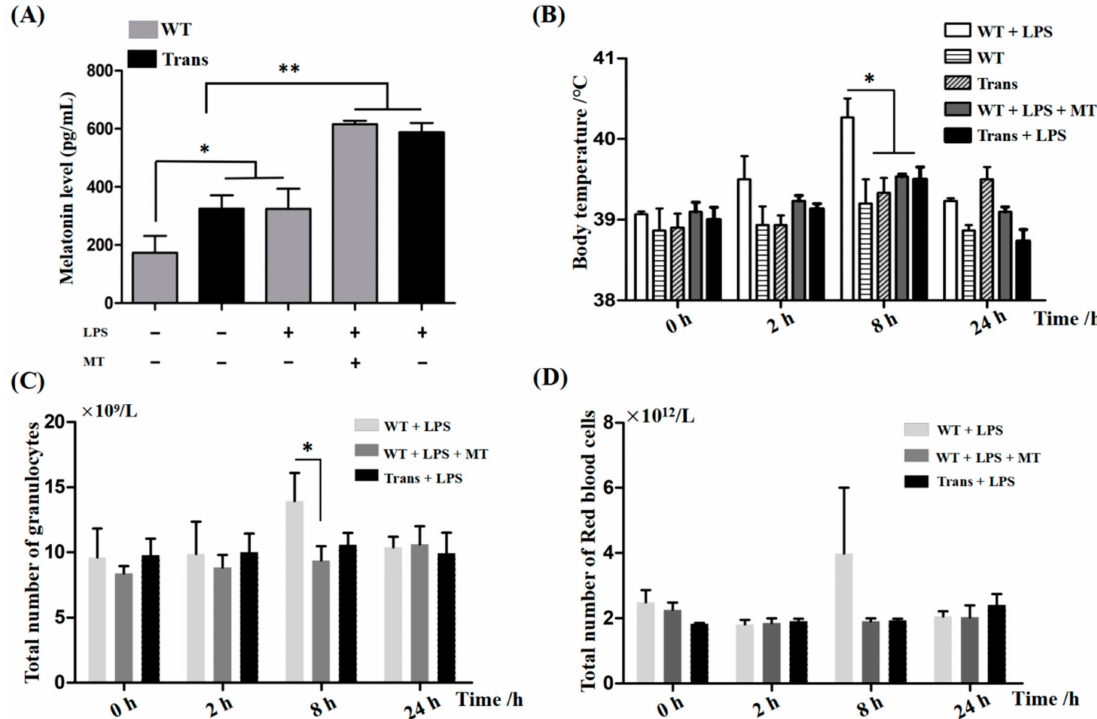
Figure 1. Effects of MT on LPS-induced inflammatory response in goats. ( A ) The serum MT levels; ( B ) body temperature; ( C ) total number of granulocysts in blood; ( D ) total number of red blood cells. MT: melatonin; LPS: lipopolysaccharide; Trans: transgenic goats; WT: wild-type goats. “*” represents significant differences, p < 0.05; “**” represents highly significant differences, p <